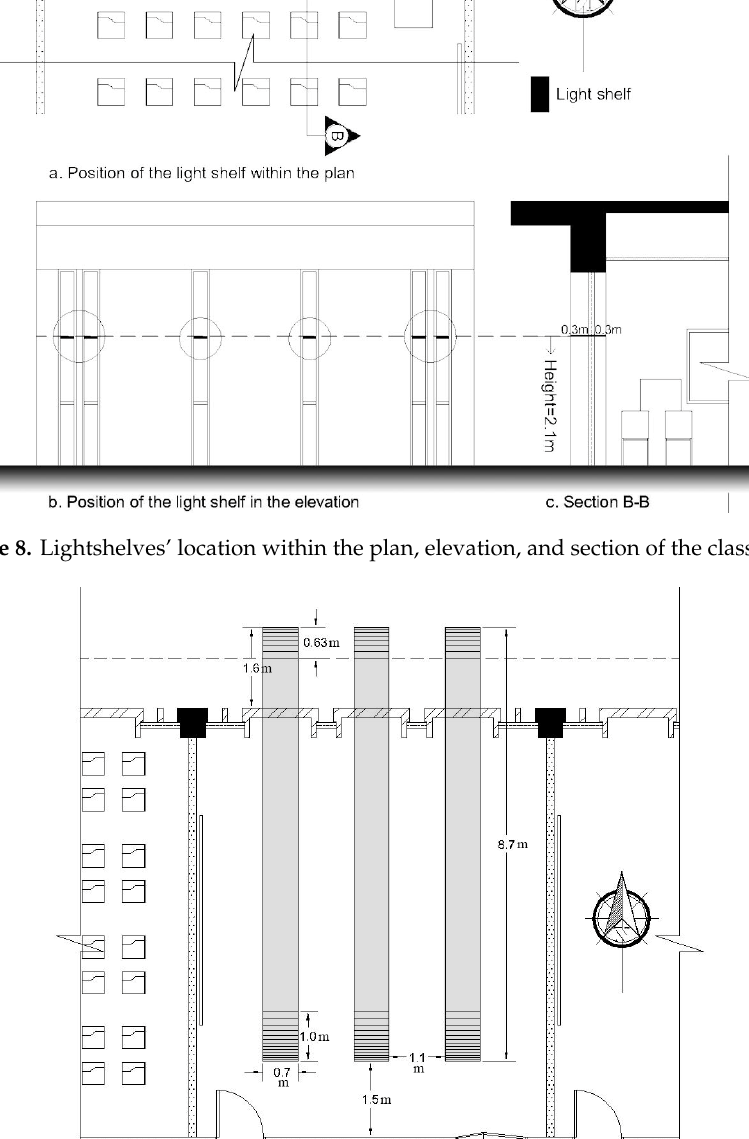
Figure 8. Lightshelves’ location within the plan, elevation, and section of the classroom.